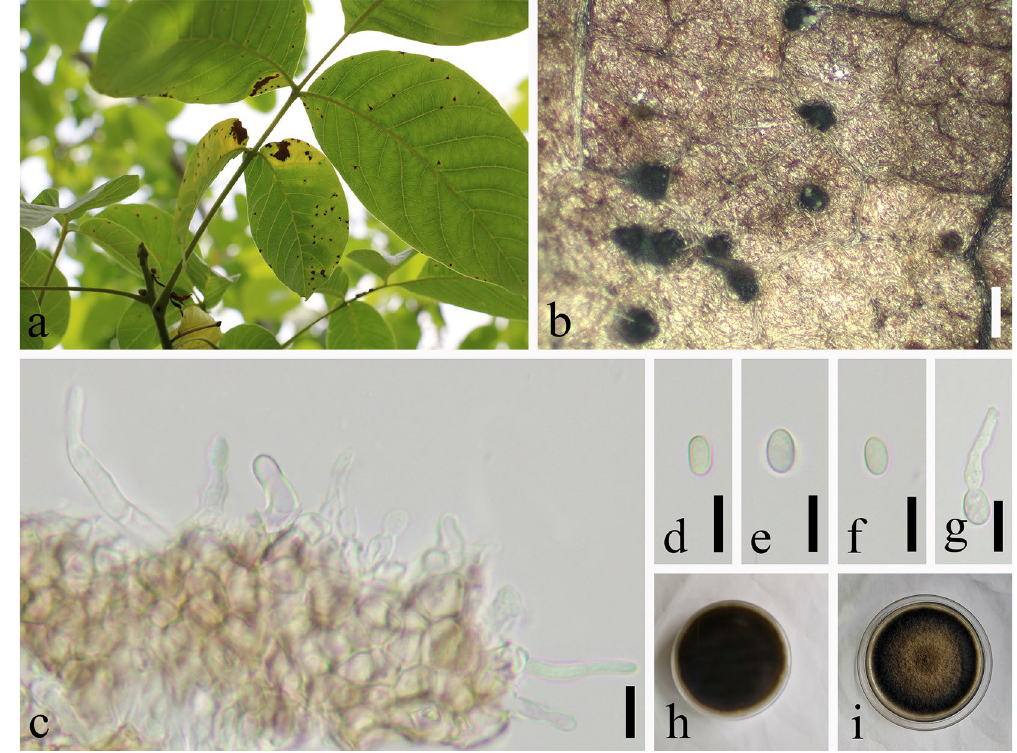
Figure 2. Phenotypic traits of Nothophoma quercina . ( a ) symptoms caused by N. quercina ; ( b ) Conidiomata on leaf surface; ( c ) Conidiogenous cells with developing conidia; ( d – f ) Conidia; ( g ) Germinating conidium; ( h , i ) Cultures on PDA. Scale bars: ( b ) = 500 μm; ( c – g ) = 10